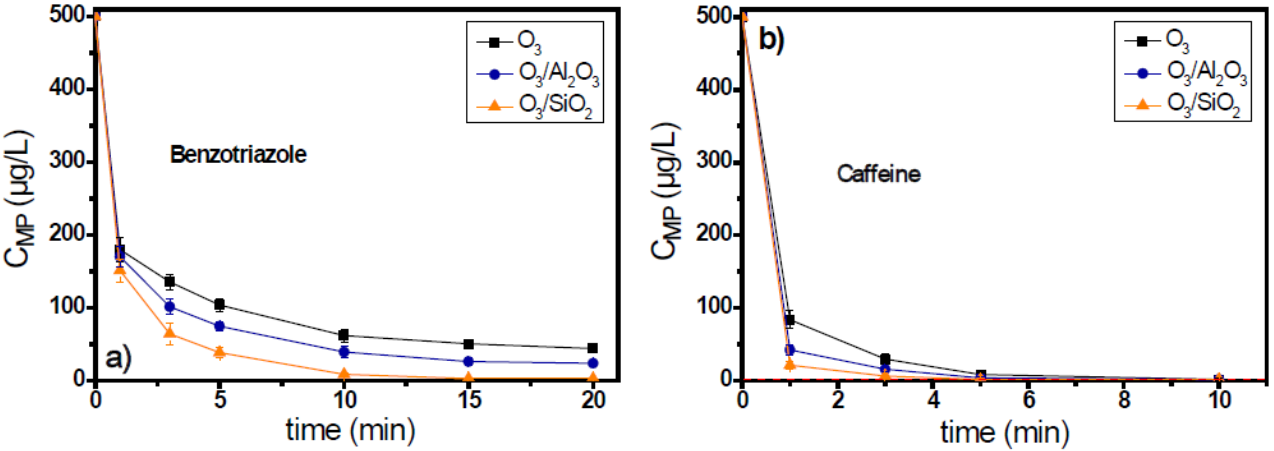
Figure 3. Degradation of micropollutants presenting moderate ozone reactivity, ( a ) benzotriazole, and ( b ) caffeine, during the application of catalytic ozonation with the use of Al 2 O 3 and SiO 2 as potential catalysts, compared to the single ozonation in natural potable water matrix. Experimental conditions: C MPs 500 μg/L, C catalyst 0.5 g/L, C O3 2 mg/L, pH 7.8, Temperature 23 ± 2 °C.